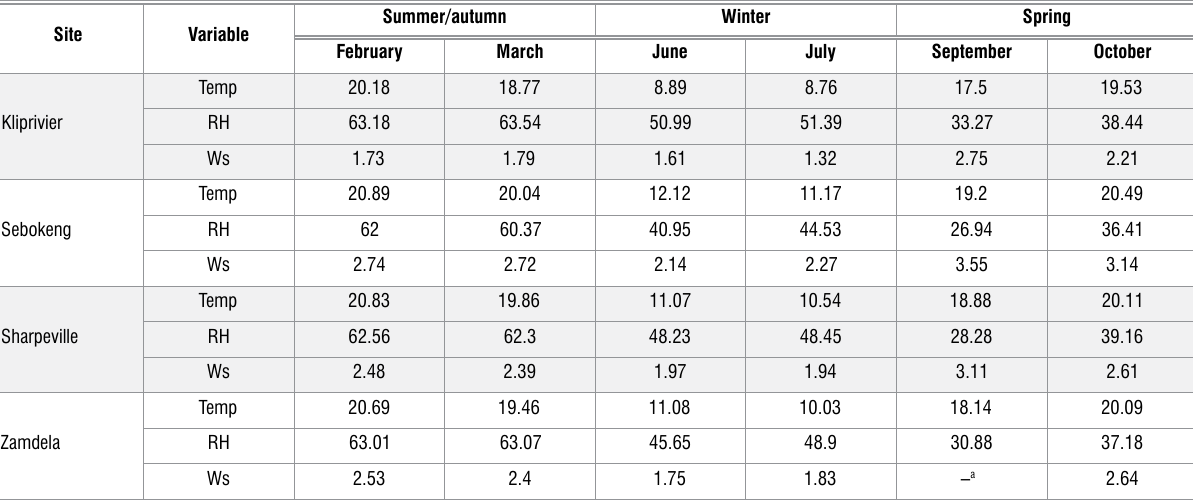
Average values of temperature (Temp, °C), relative humidity (RH, %) and wind speed (Ws, m/s) during the summer/autumn, winter and summer campaigns Site